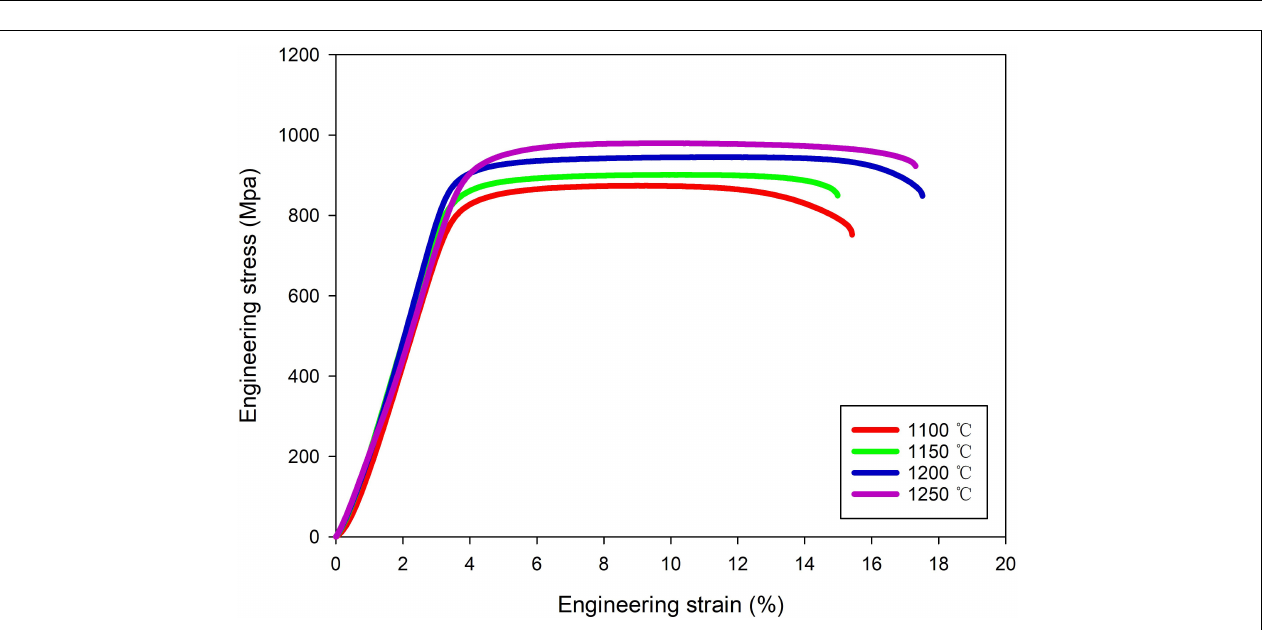
FIGURE 7 | Stress-Strain curves for the Ti80 samples sintered at different temperatures for 4 h.